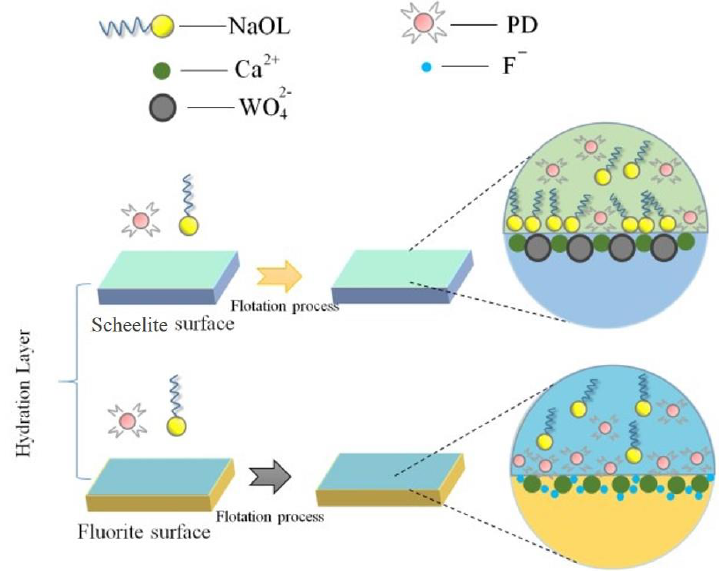
Figure 12. NaOl and PD adsorption mechanisms on scheelite and fluorite surfaces.